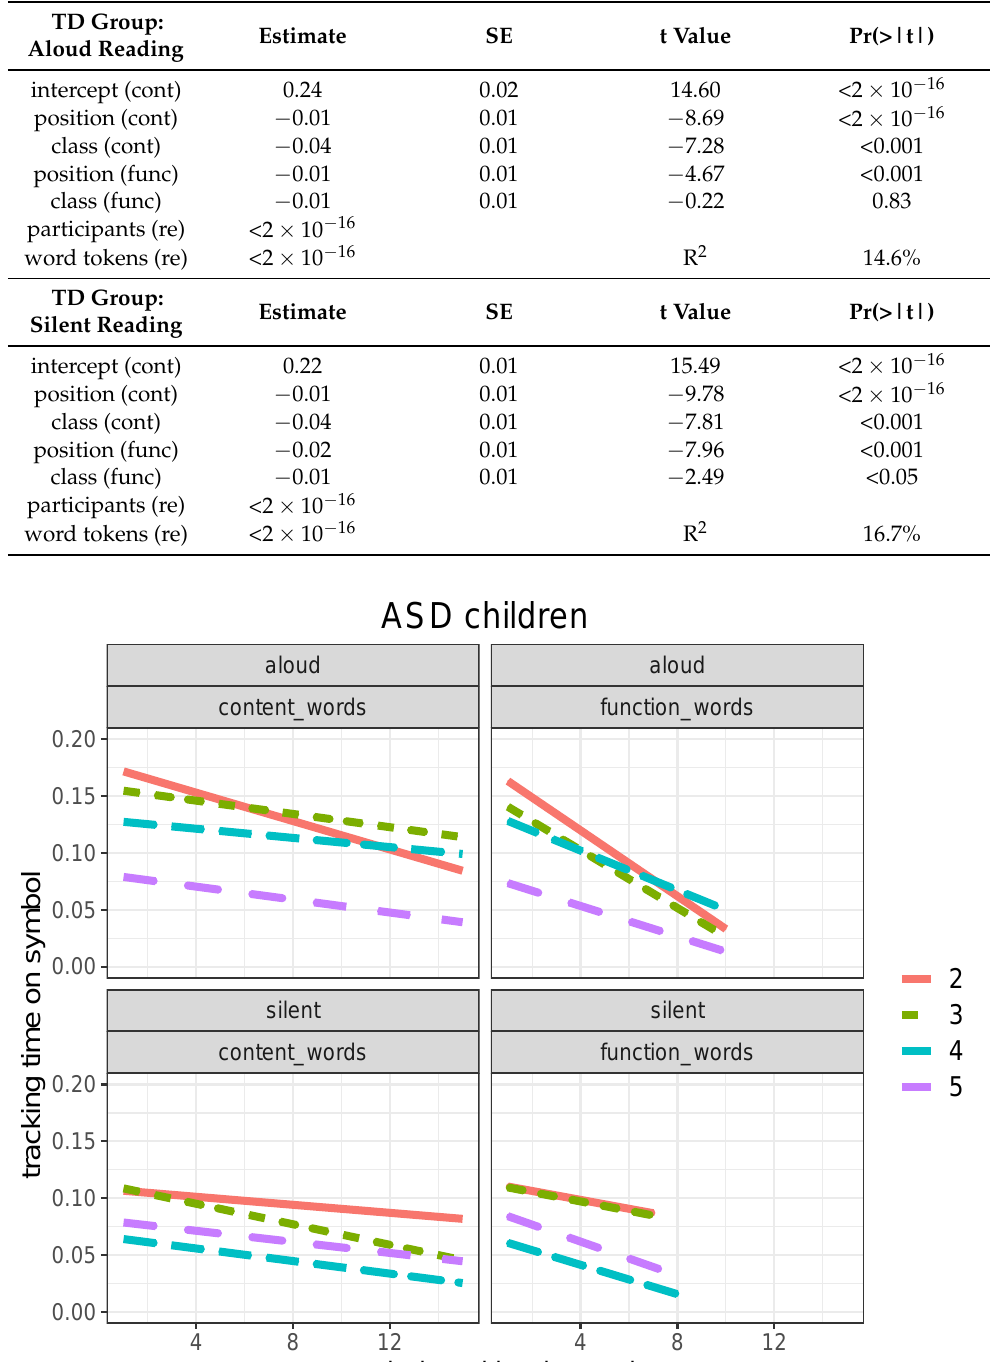
Table 7. GAM coefficients for models fitting tracking time on symbols as a function of symbol position in the word ( position ) in interactions with content vs. function words ( cont, func ) and grade level ( class ) for the two reading modalities. Participants in the control group (TD) and word tokens are added as random effects ( re ).